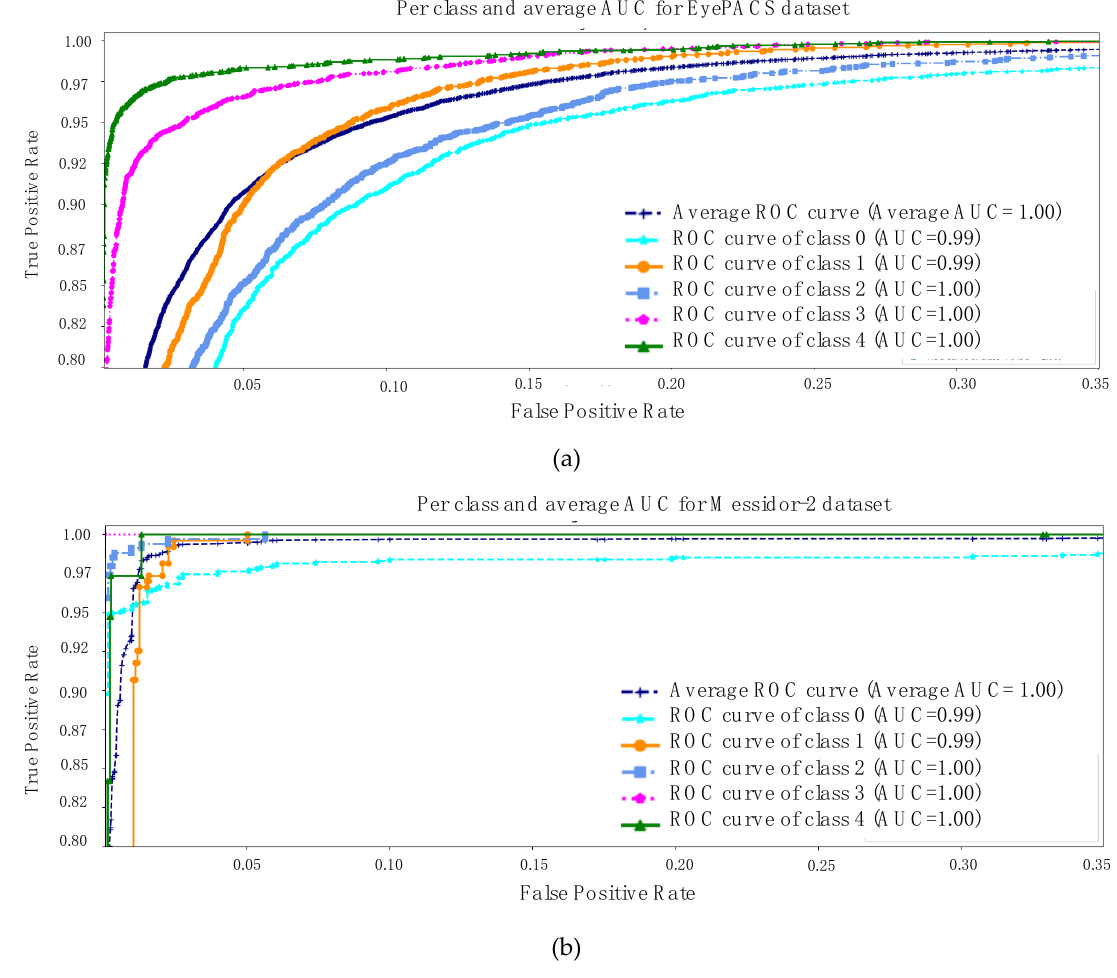
Figure 4. ( a ) AUC results for EyePACS dataset, ( b ) AUC result for Messidor-2. The receiver operating characteristic (ROC) curve for each individual class was determined to compute the averages.